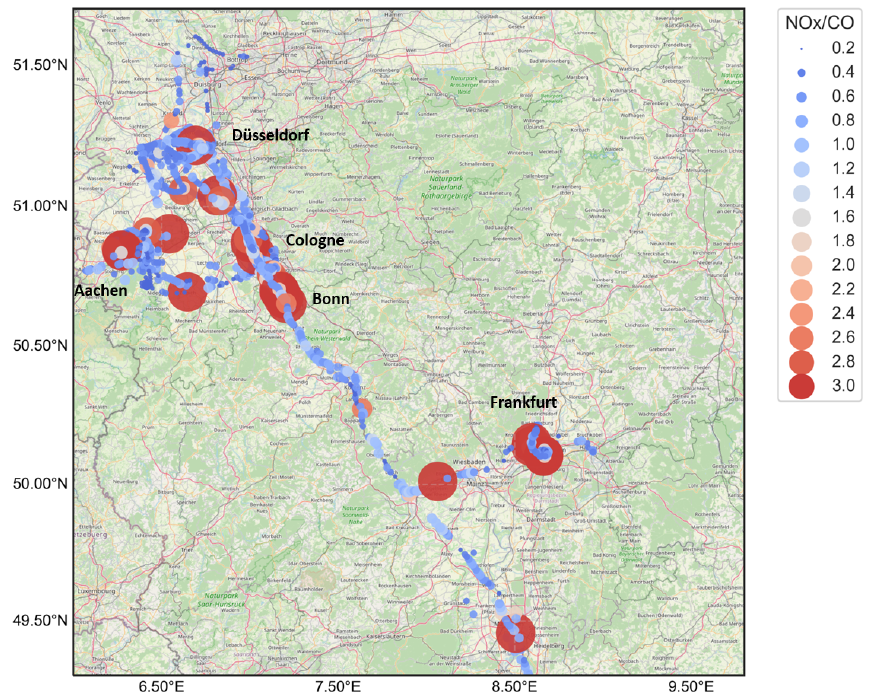
Figure 6. Identified areas of high NO x relative to CO emissions in Germany during the Zeppelin flights (© OpenStreetMap contributors 2021. Distributed under the Open Data Commons Open Database License (ODbL)